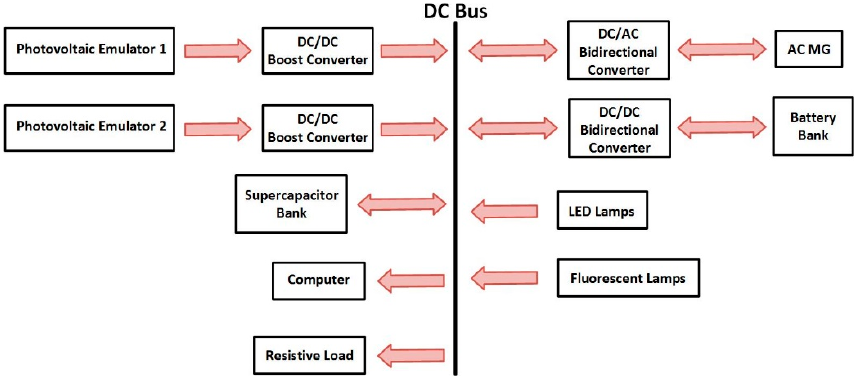
Figure 1. Direct current microgrid (DC-µG) block diagram.